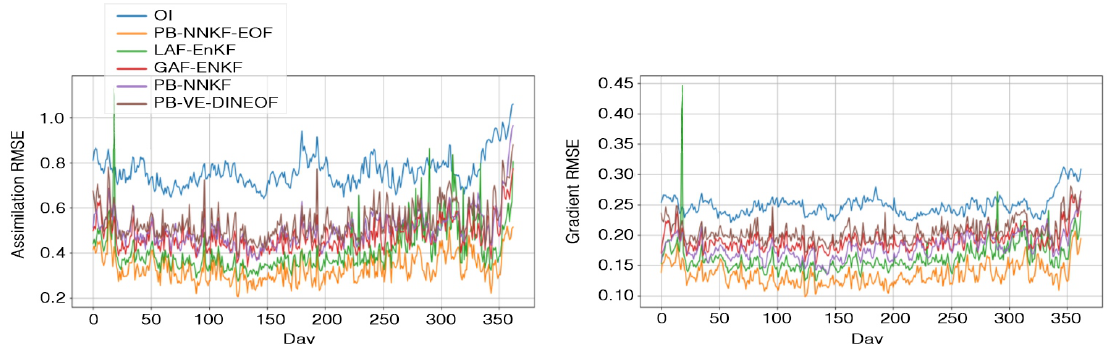
Figure 3. Reconstruction and gradient RMSE times series for the selected